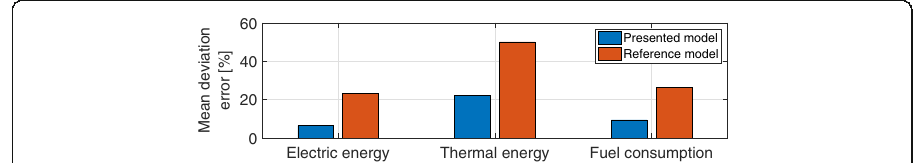
Fig. 3 Comparison of both models using the mean deviation error between the mathematical model and the real CHP